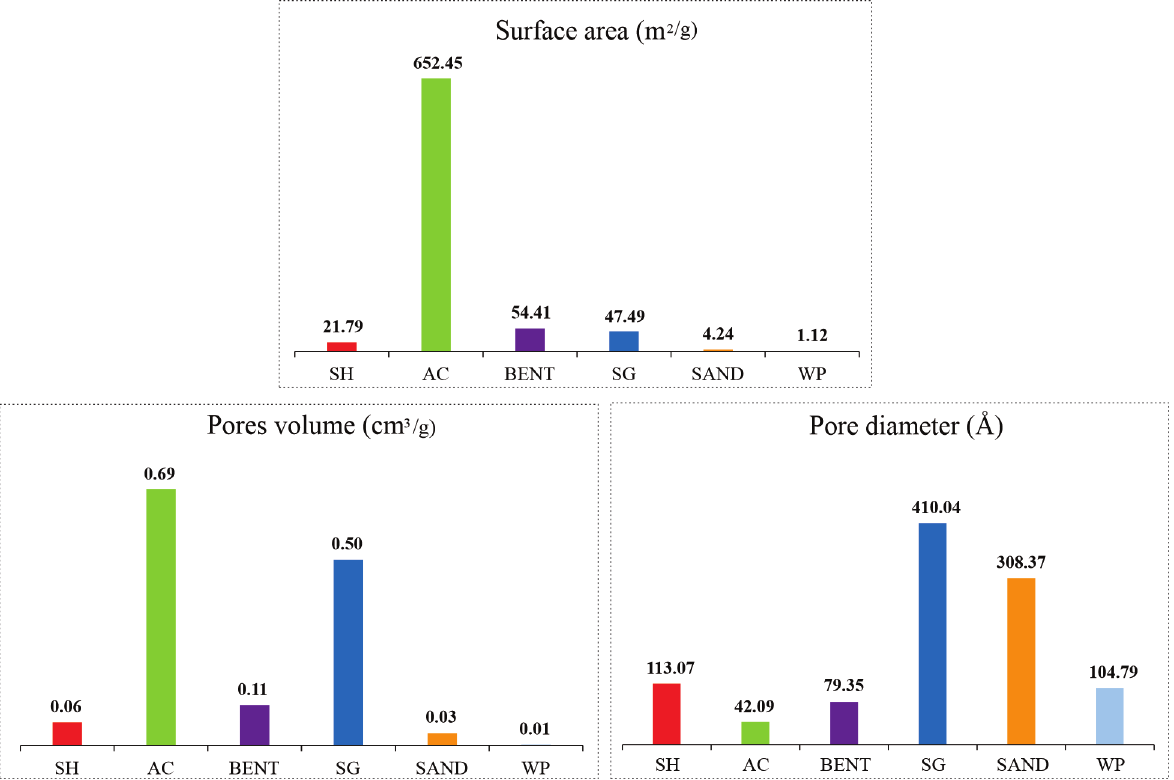
Figure 2. Textural properties of adsorbents: surface area, pores volume and pore average